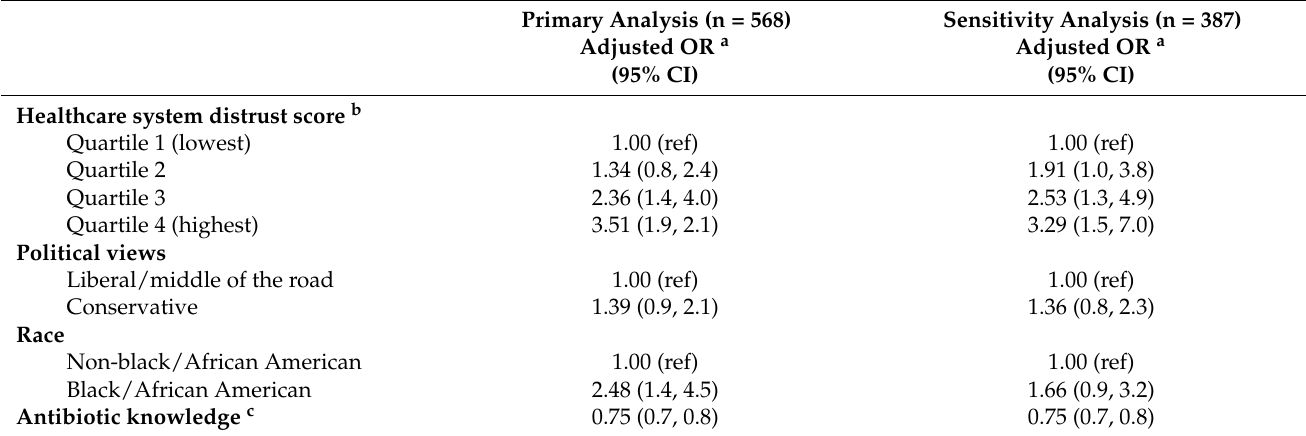
Table 3. Results of primary logistic regression analysis compared to sensitivity analysis, restricted to recent antibiotic users only.